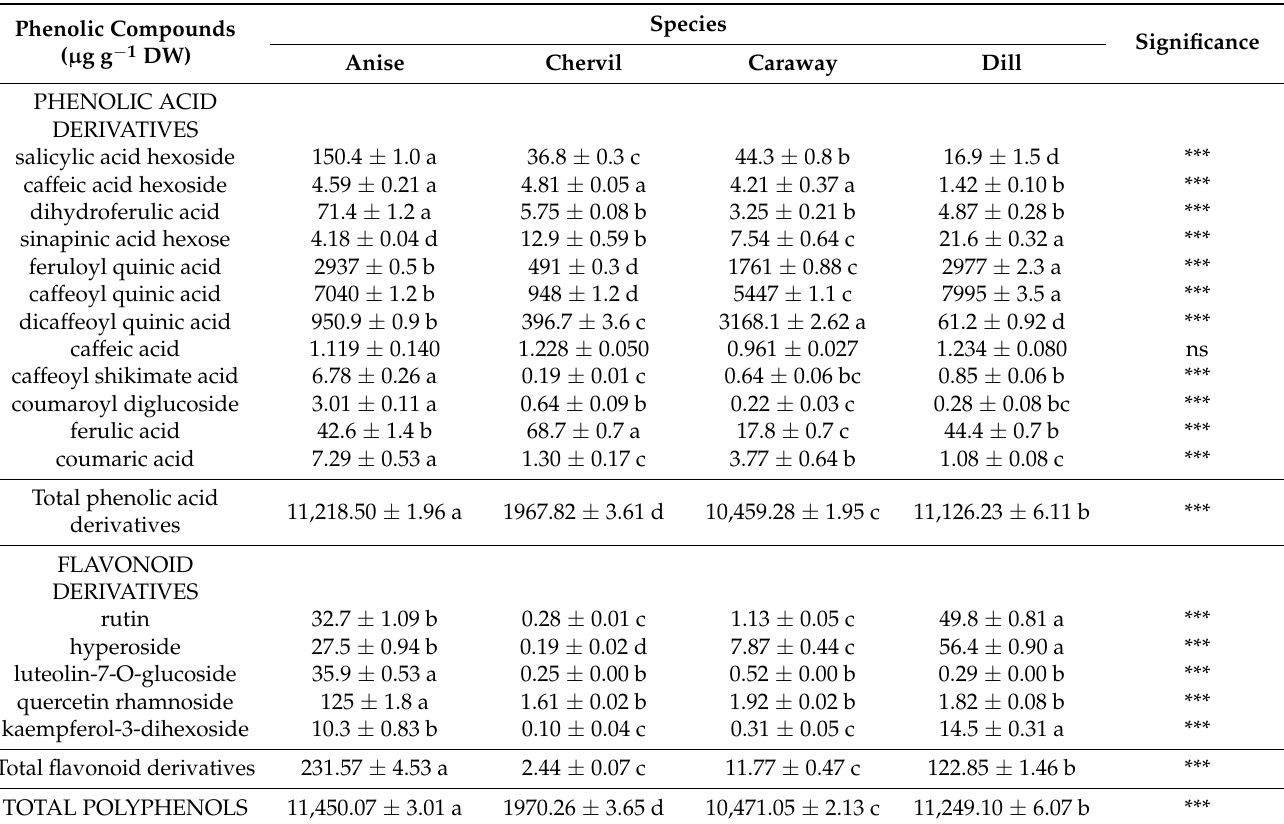
Table 4. Phenolic profile of four Apiaceae microgreens grown in controlled environment